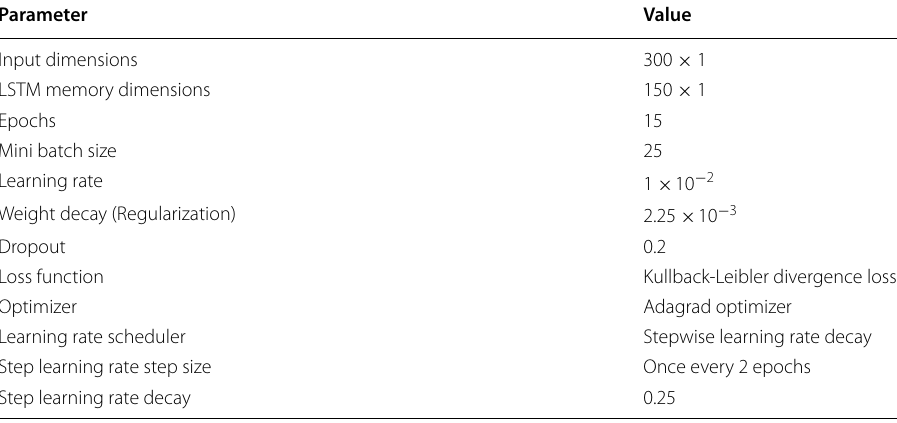
Table 1 Hyper-parameter values of